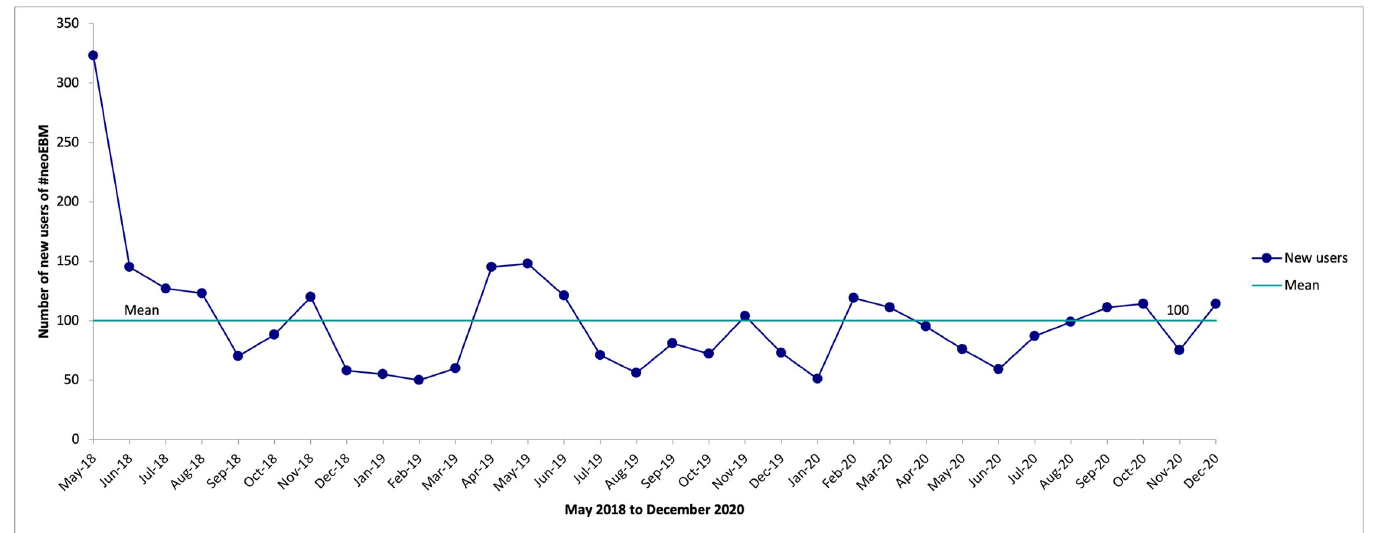
Fig 3. Time-series graph of numbers of new #neoEBM users (monthly